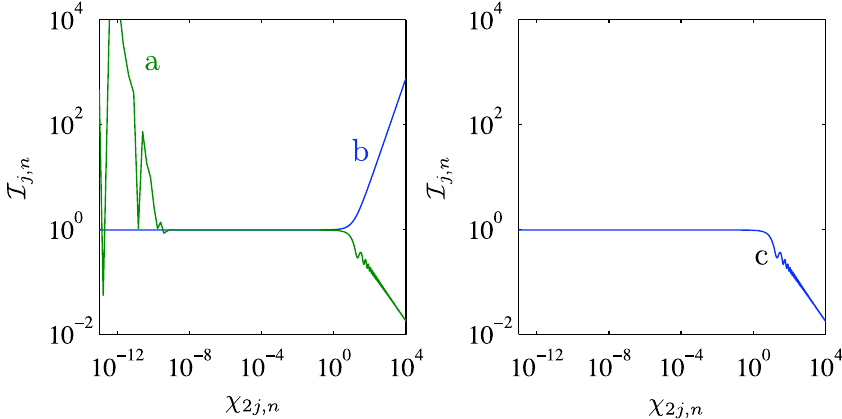
FIG. 1. (Color) Various model calculations of integral I j;n for d(cid:4) ¼ 1 , v 0 j;n ¼ 1 , v 1 j;n ¼ 2 , (cid:7) 1 j;n ¼ 1 , and varying (cid:7) 2 j;n . (a) Calculation of integral using Fresnel integral form. (b) Calculation using Taylor series expansion form of integral. (c) Calculation using finite differenced integral with 10 7 steps and Simpson’s